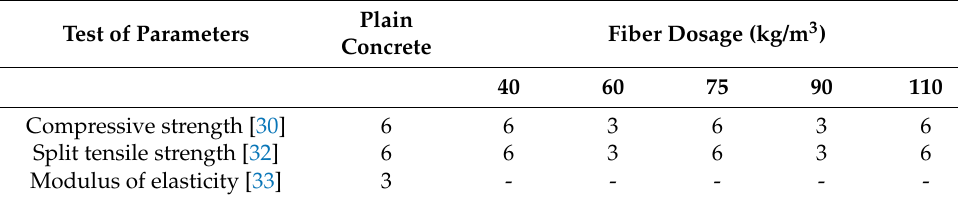
Table 2. Parameters of basic tests and the number of samples (number).